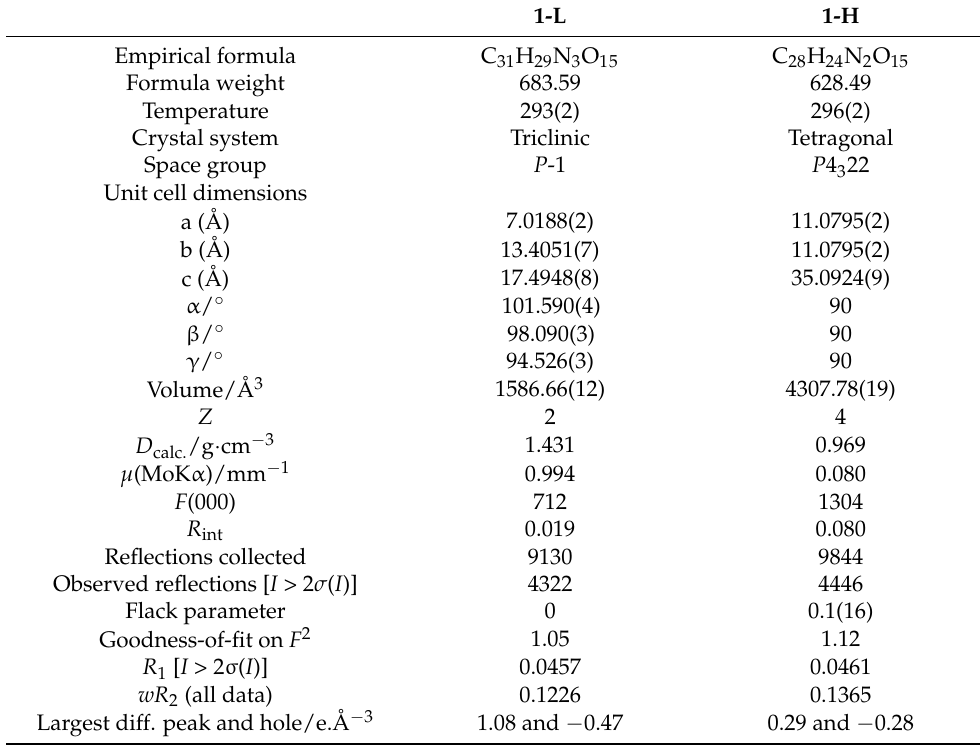
Table 1. The Crystallographic data for 1-L and 1-H a .